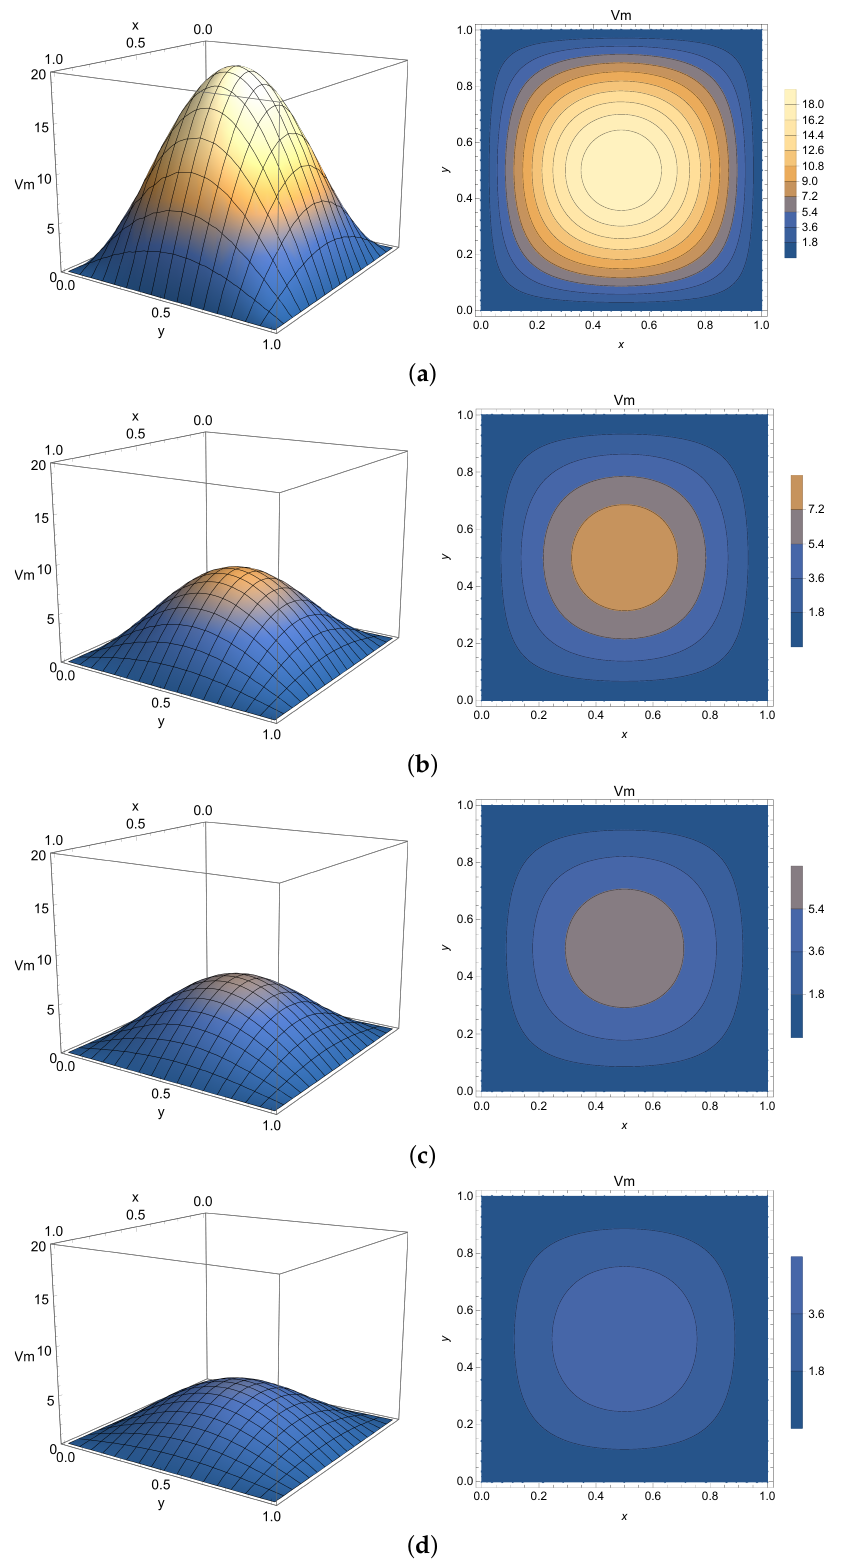
Figure 9. Two-dimensional homogeneous solution describing the potential plateau after depolarization: Equation (27) with α = 0.5. ( a ) t = 0 µ s, ( b ) t = 250 µ s, ( c ) t = 500 µ s, ( d ) t = 1000 µ